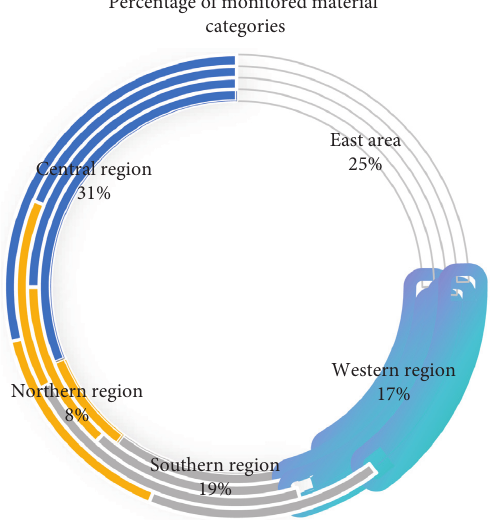
Figure 3: Percentage of monitored material categories.